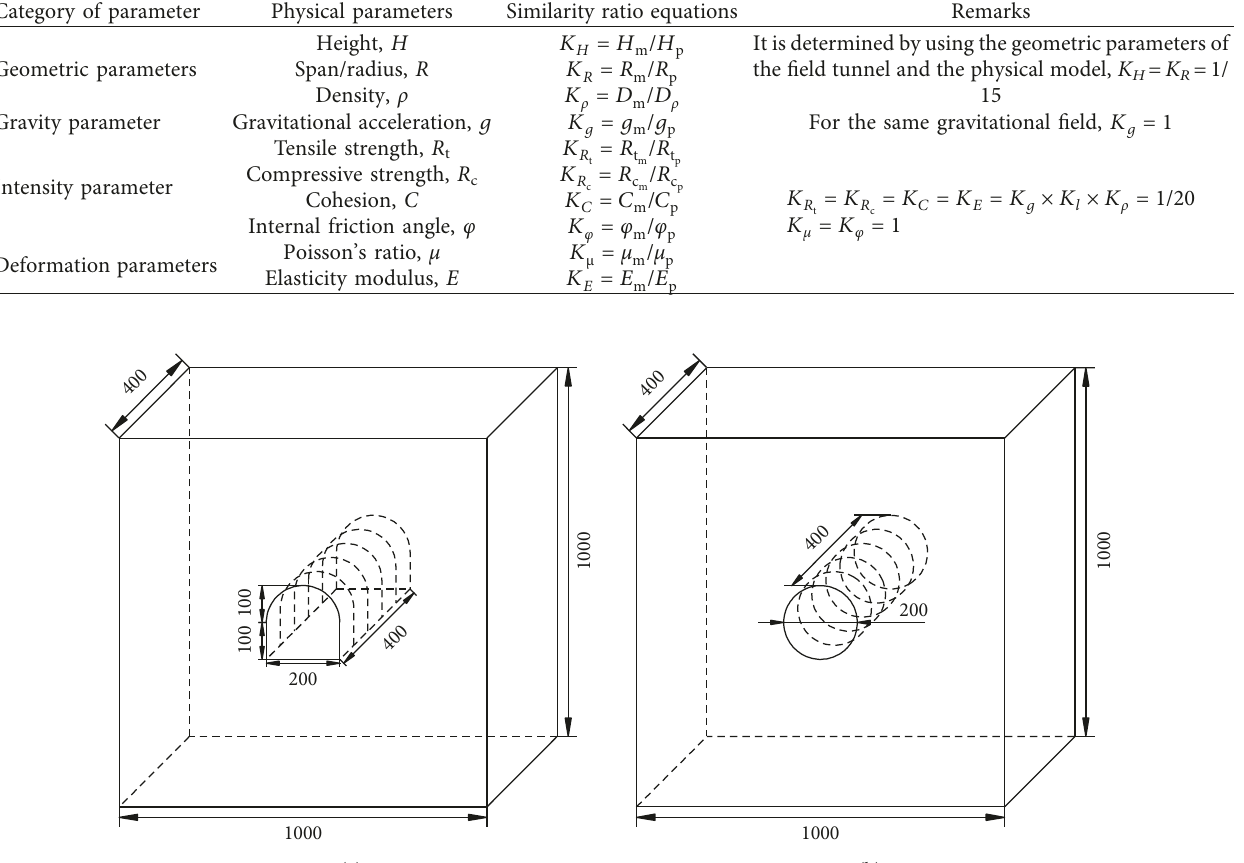
Table 1: The principle of determining physical model parameters.